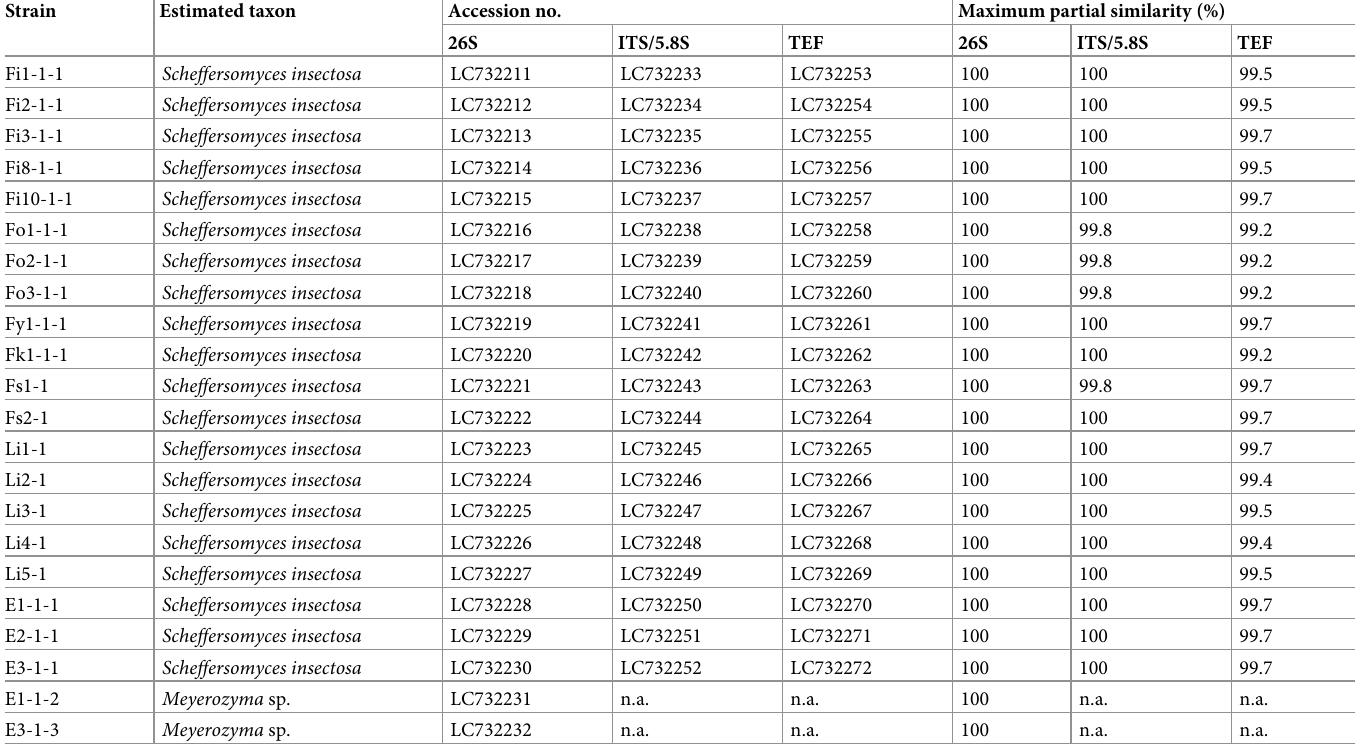
Table 3. DDBJ/EMBL/GenBank accession numbers for each Leptura ochraceofasciata -related yeast strain sequenced. Strain Estimated taxon